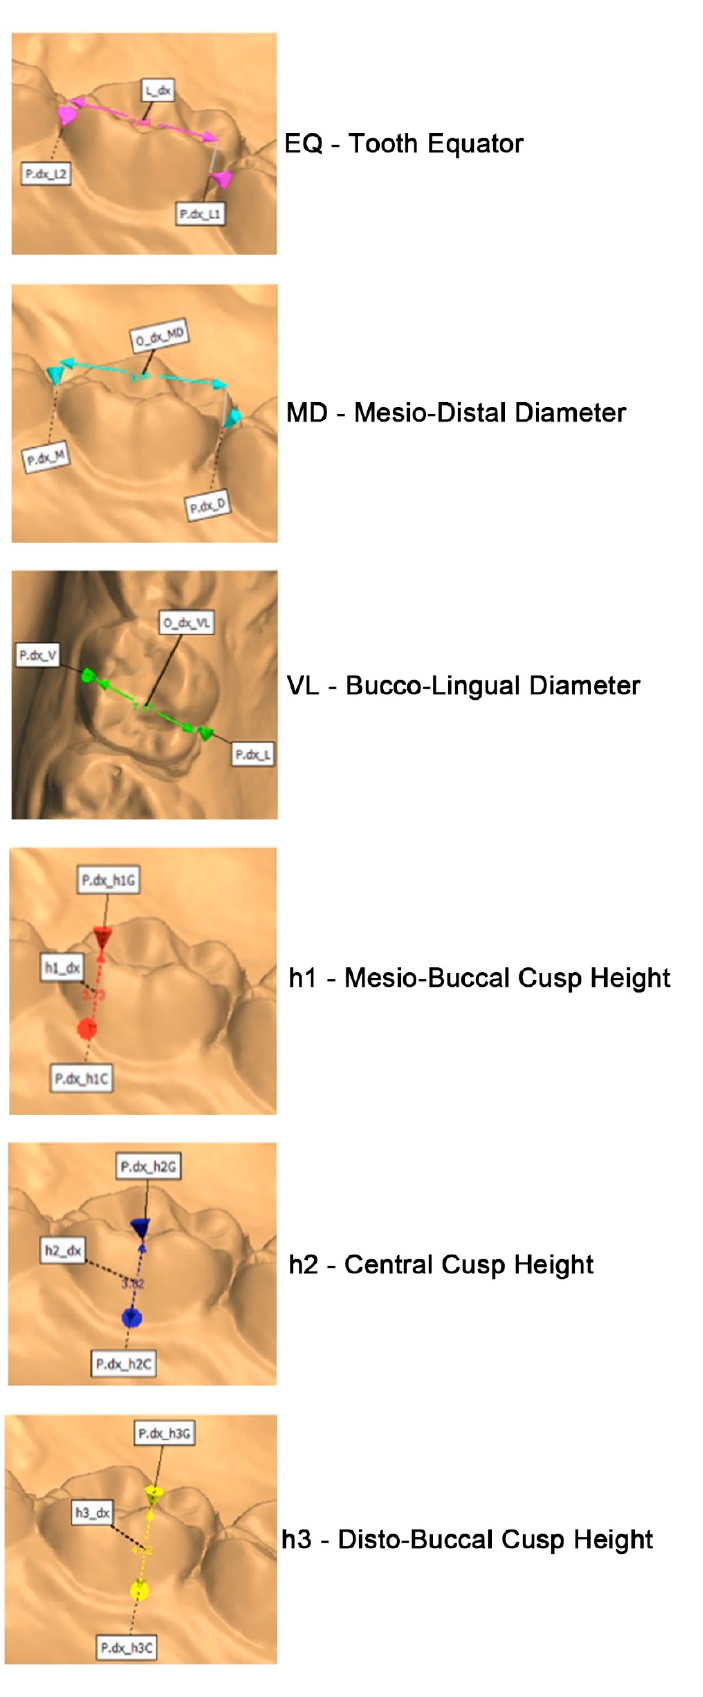
Figure 3. Digital measurements performed.